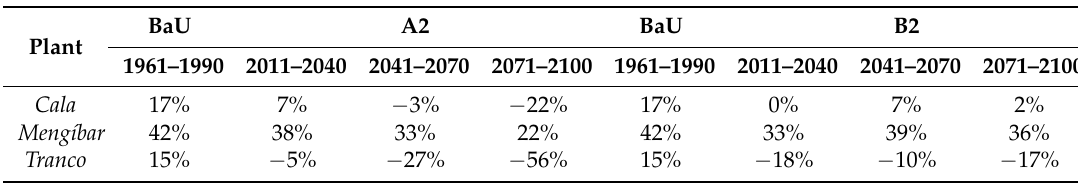
Table 8. Evolution of operating margins (%) over